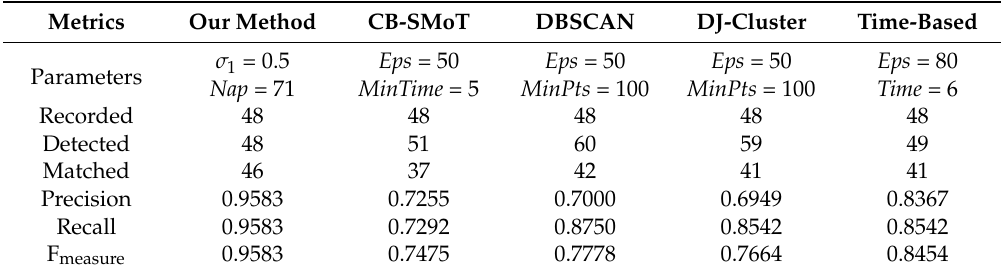
Table 3. Experimental results using data collected by the